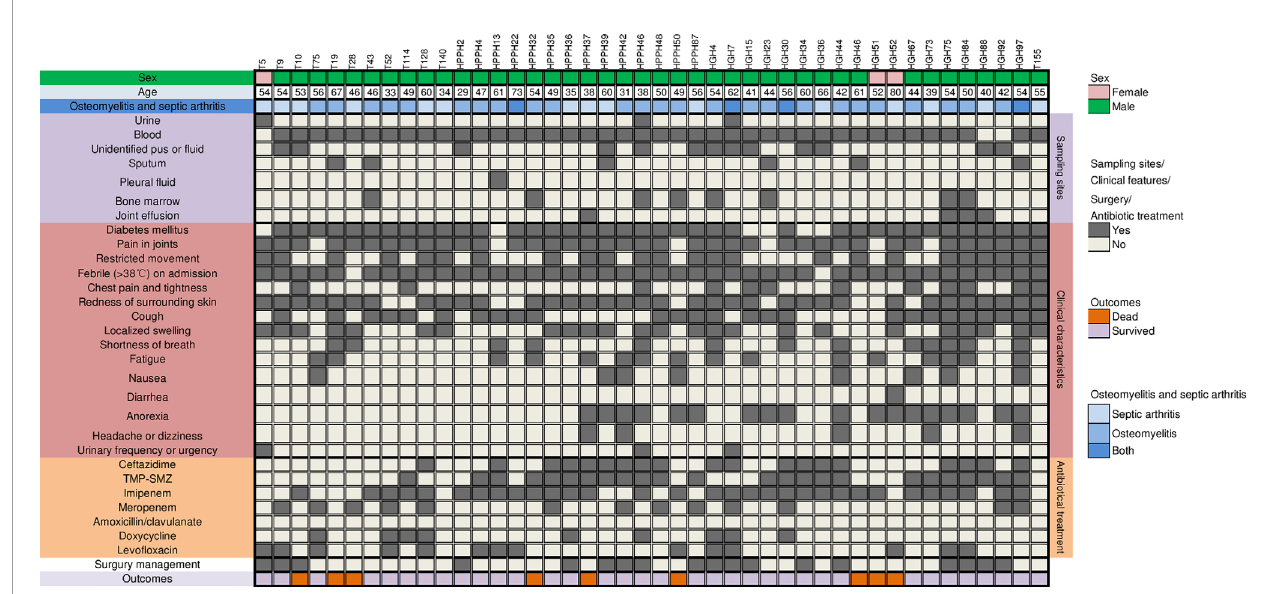
FIGURE 1 | Clinical features and antibiotics treatment in 44 patients having melioidotic osteomyelitis and septic arthritis. trimethoprim/sulfamethoxazole (TMP-SMZ).